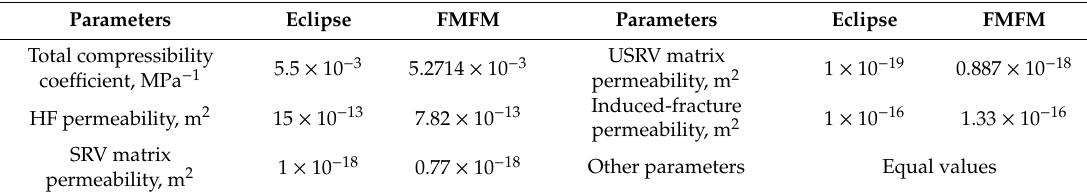
Table 2. Comparison of matching results of FMFM and numerical model parameters by ES-MDA.